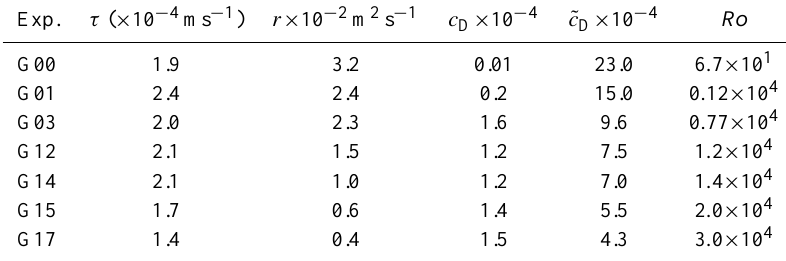
Table 2. Estimated parameter values in the numerical experiments.